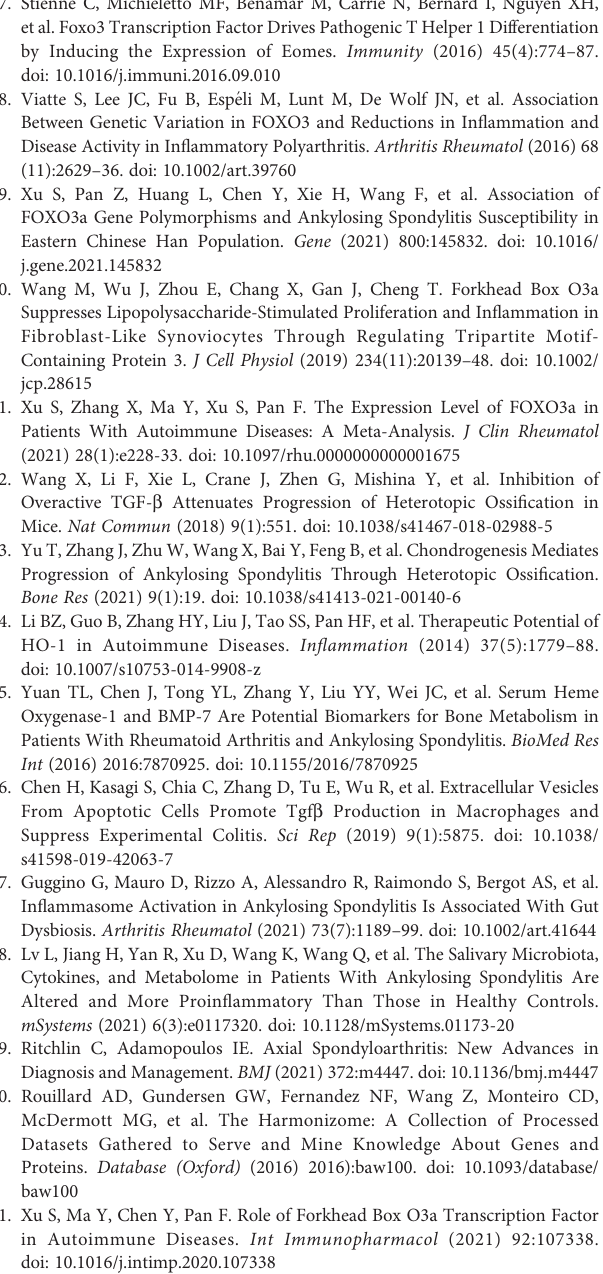
Supplementary Figure 1 | Validation of FOXO3a overexpression and silencing. (A) Lv-FOXO3a signi fi cantly elevated the transcription level of FOXO3a. (B) Si- FOXO3a-P1 but not Si-FOXO3a-P2 or Si-FOXO3a-P3 obviously inhibited FOXO3a expression. (C) Representative immunoblots of FOXO3a protein. (D) Quanti fi cation for FOXO3a. All data were expressed as mean ± SEM of three independent